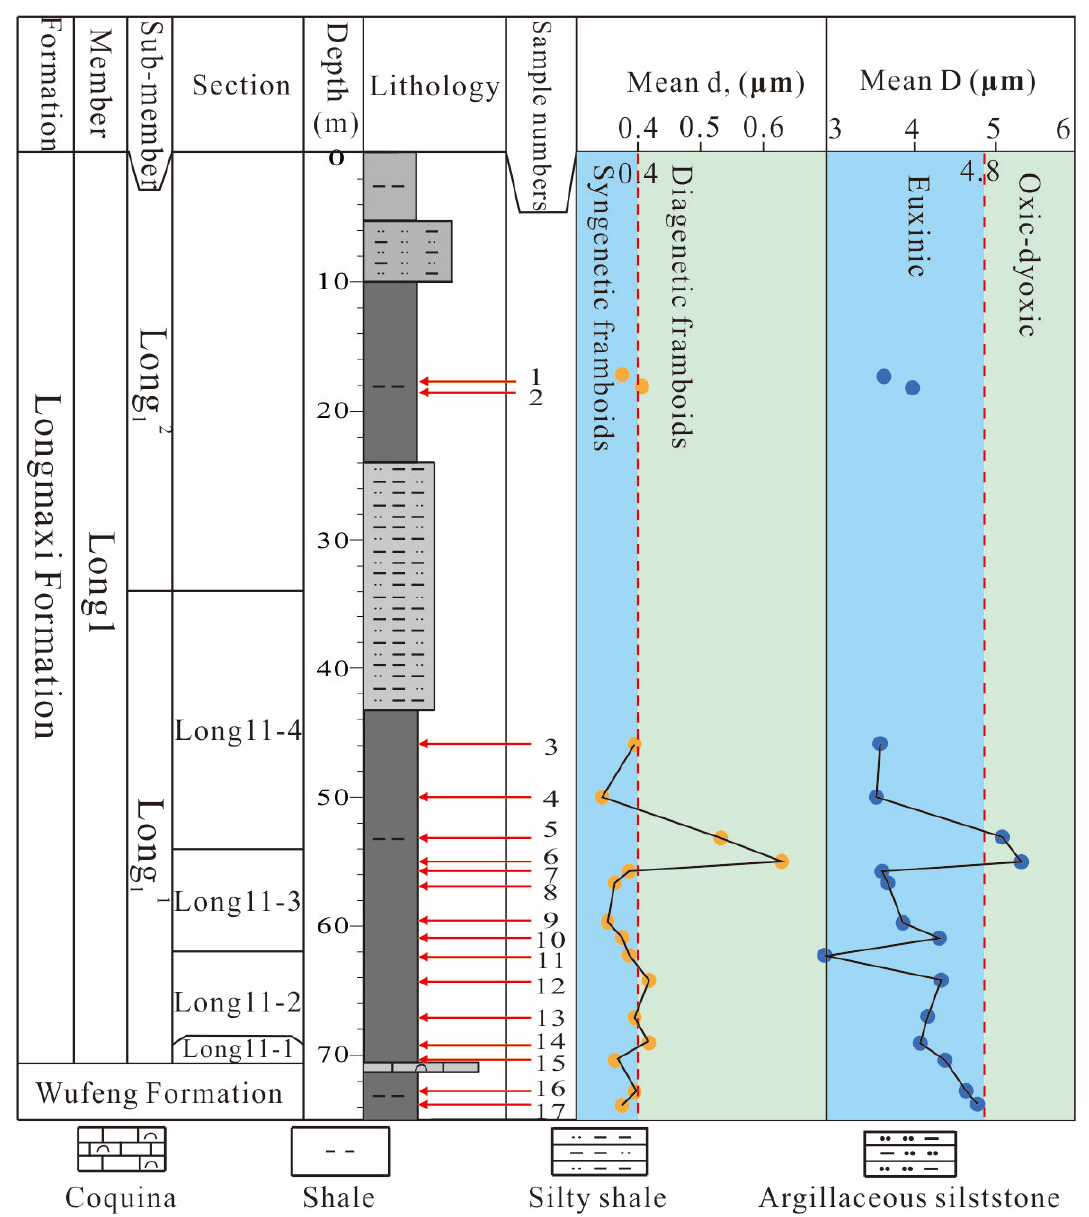
Figure 7. The mean, D, mean, d, and redox condition variations in the Wufeng–Longmaxi marine shale of the X well in the southeast Sichuan Basin.